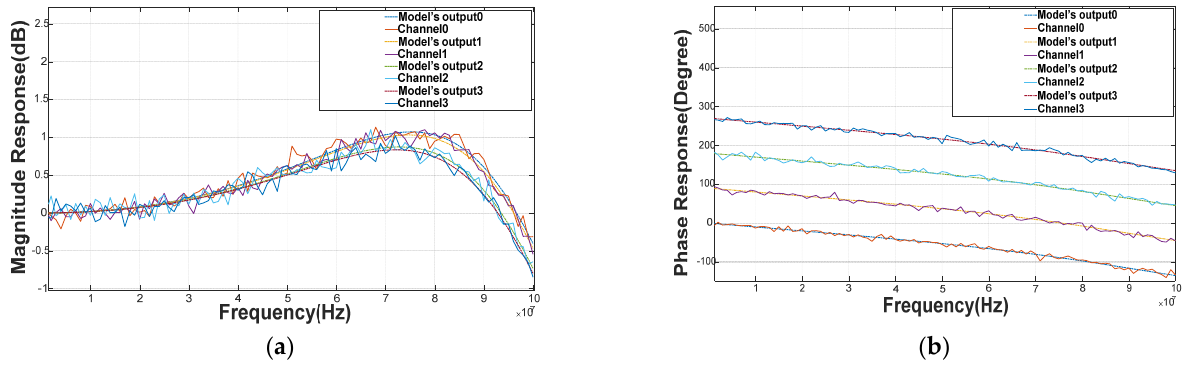
Figure 10. Identification Model Output and Actual Output of Four-Channel TIADC system: ( a ) amplitude and frequency; ( b ) Phase and